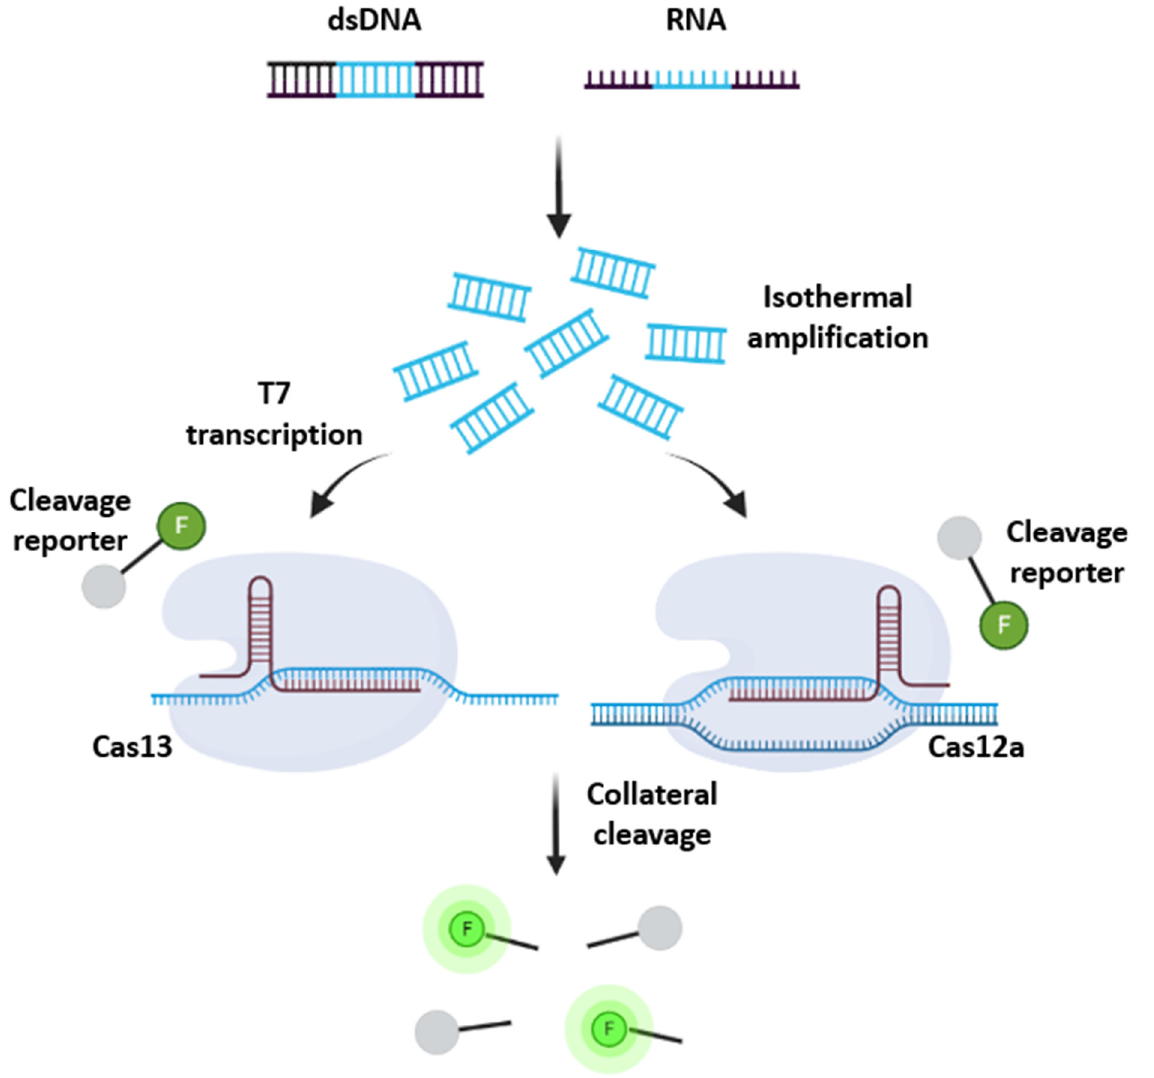
Figure 4. The basic schematic principle of CRISPR/Cas-based detection. DNA or RNA are amplified by isothermal amplification. Binding of the crRNA to the complementary target sequence activates the Cas enzyme and triggers collateral cleavage of quenched fluorescent reporters. Thereby, Cas13a (used in SHERLOCK) or Cas12a (used in DETECTR) indicate the presence of RNA or DNA target sequences, respectively. Created with BioRender.com.